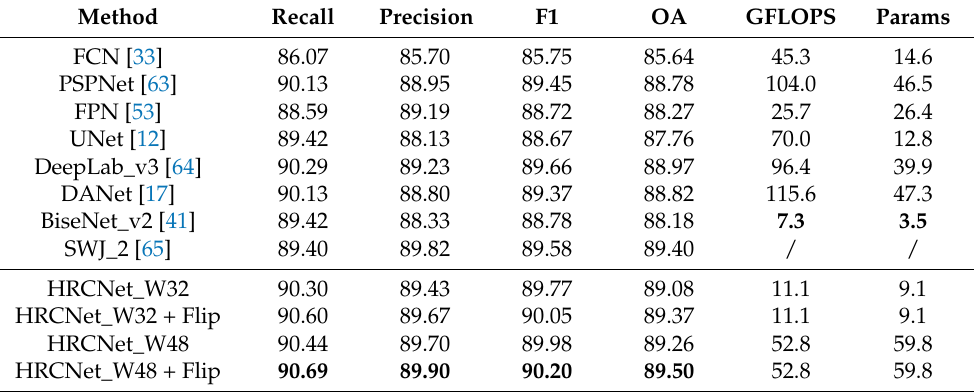
Table 4. Results evaluated by Recall (%), Precision (%), F1 (%), OA (%), Giga Floating-point Opera-